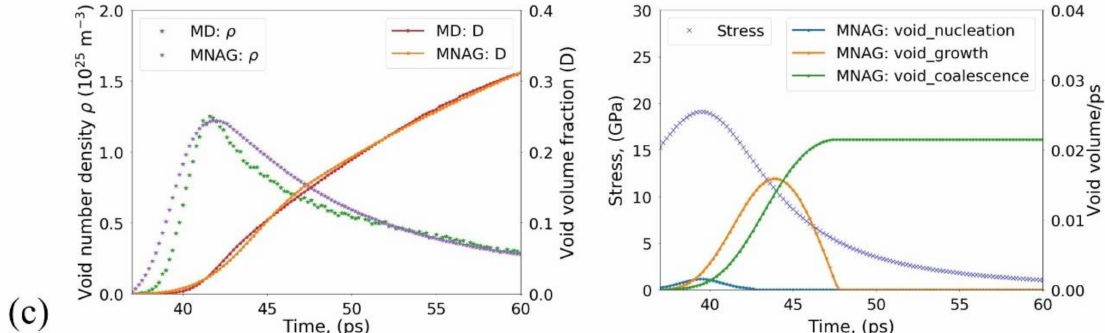
Figure 5. The MNAG model fitted to nanocrystalline Ta with different grain sizes: ( a ) 20 nm, ( b ) 10 nm, ( c ) 5 nm. The left-hand panels show the void number density and damage based on MD and MNAG model, and the right-hand panels show the contribution from void nucleation, growth, and coalescence term over time based on the MNAG